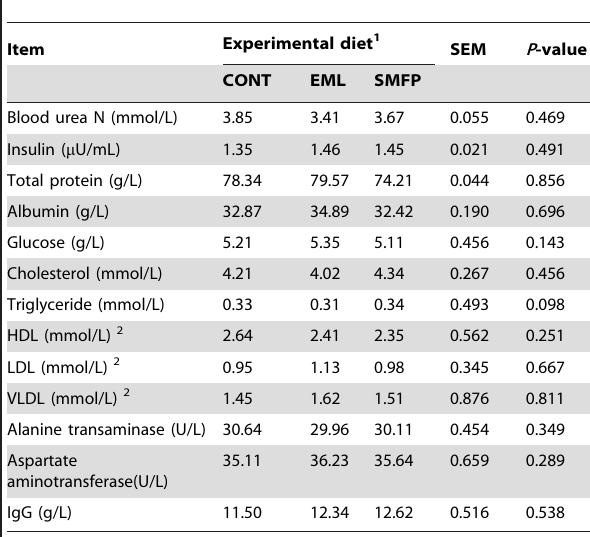
Table 5. Carcass characteristics of finishing steers fed a total mixed ration supplemented with ensiled mulberry leaves (EML) or sun-dried mulberry fruit pomace